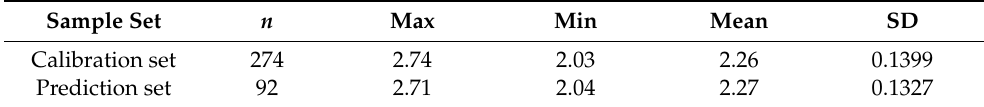
Table 2. Acidity distributions of green